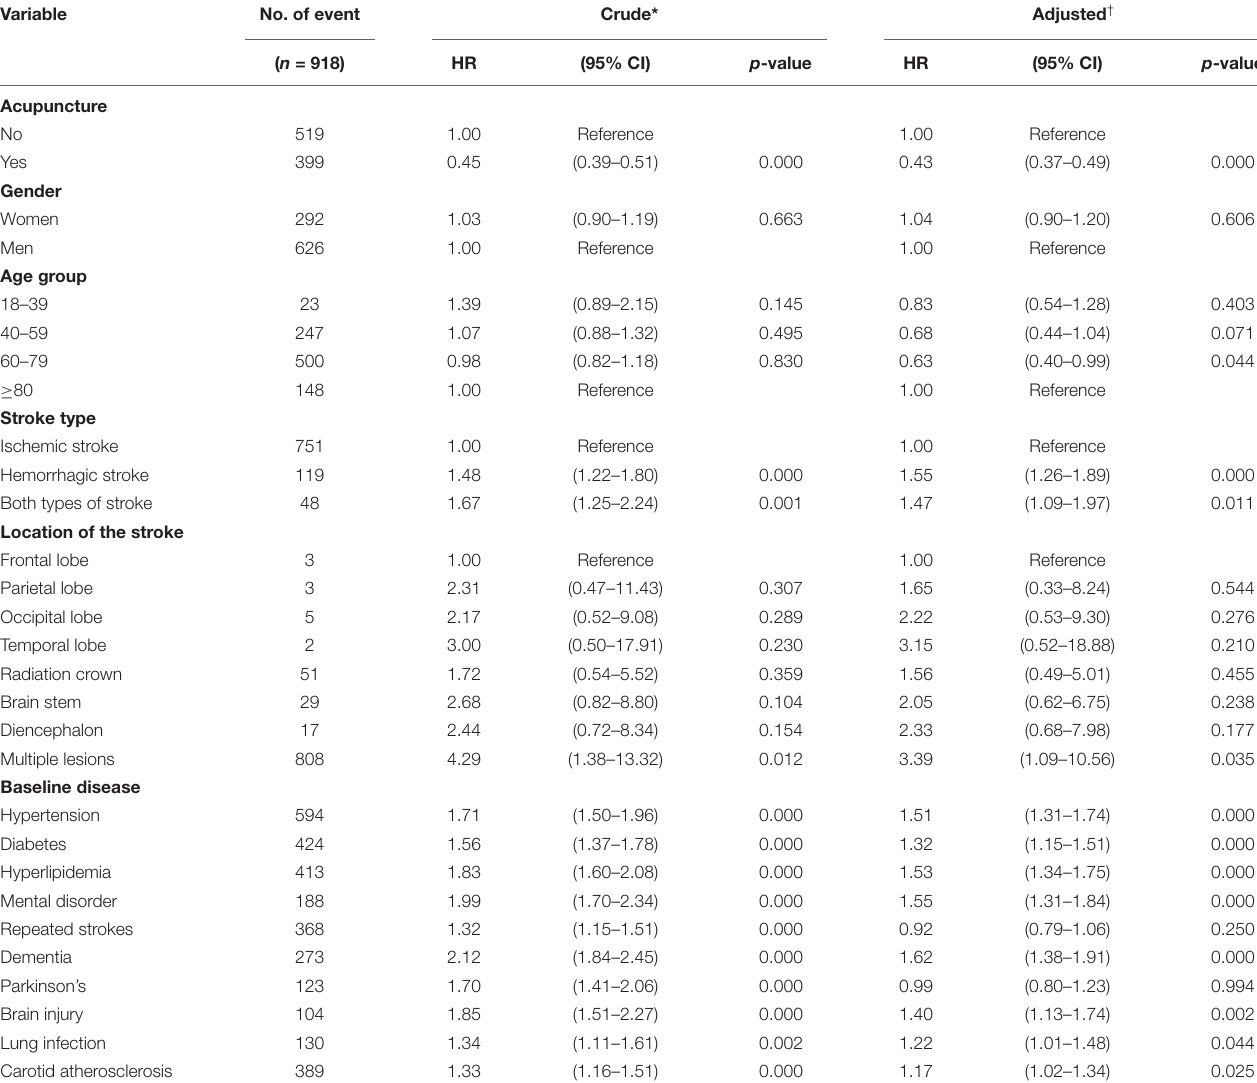
TABLE 2 | Cox model with hazard ratios and 95% confidence intervals of each covariate that developed into dysphagia after stroke.